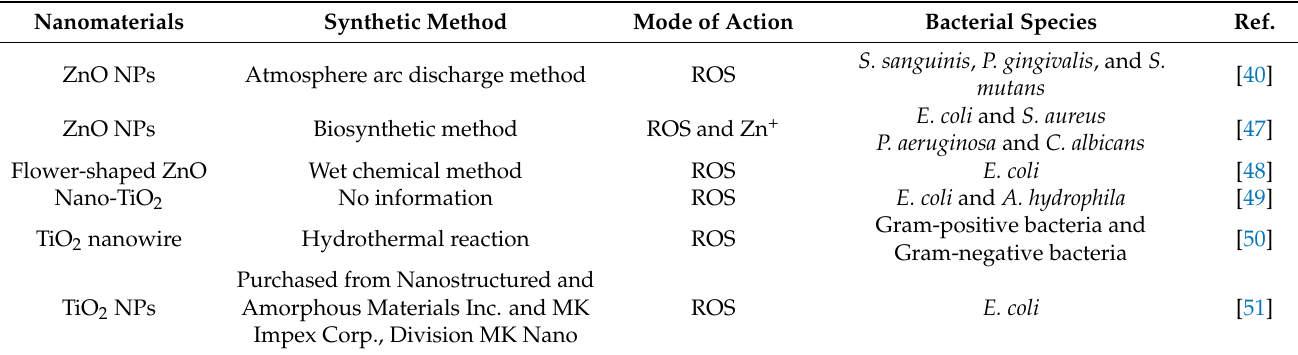
Table 2. The antibacterial mechanism and synthetic method of metal oxide